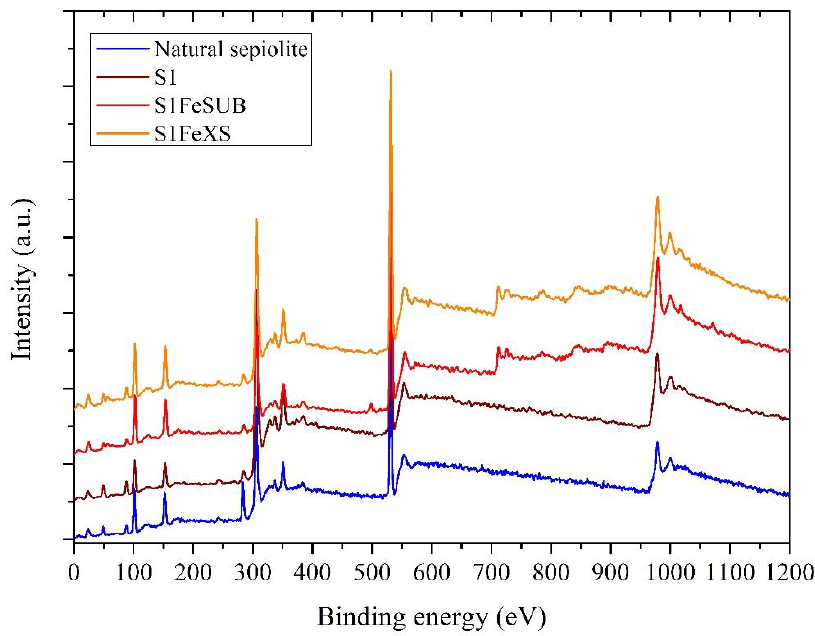
Figure 7. XPS survey spectra of natural sepiolite (Tolsa Pangel S9), S1, S1FeSUB and S1FeXS powders.